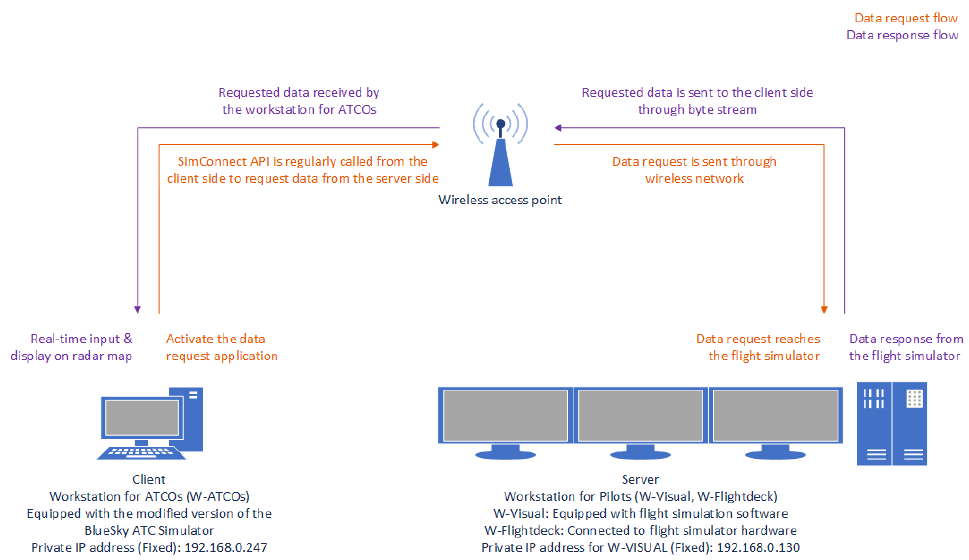
Figure 3. Data flow diagram.